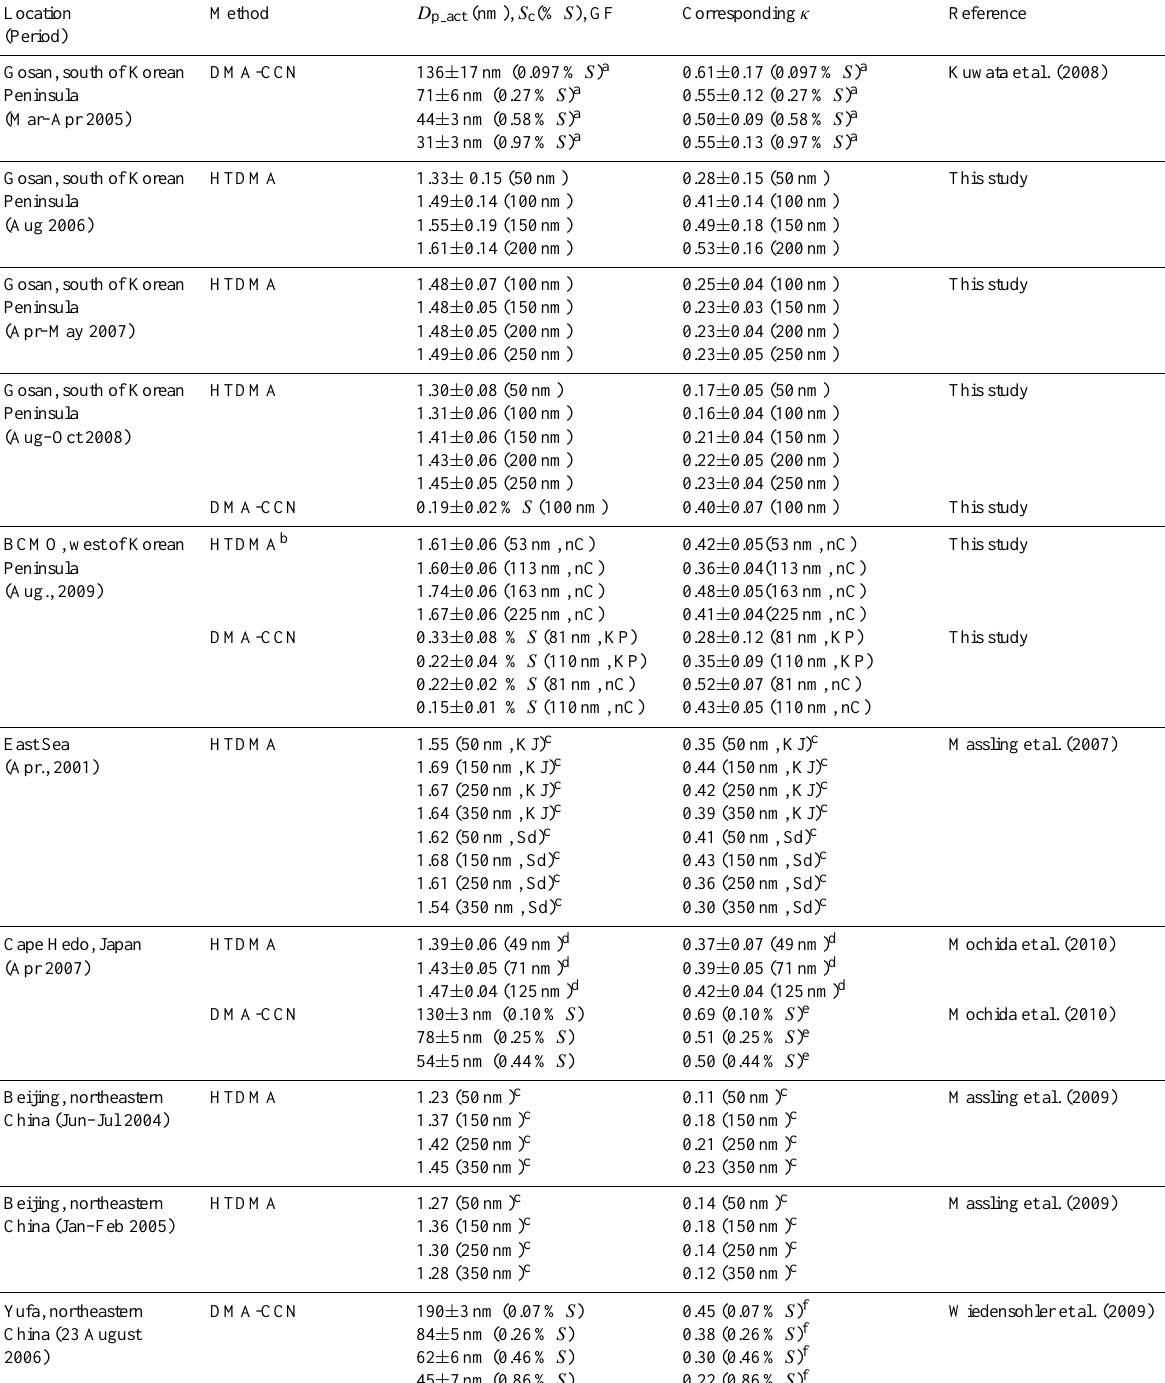
Table 3. Comparison of κ values obtained from various hygroscopicity studies in East Asia. In BCMO 2009 and Massling et al. (2007), the results were classified by air mass back trajectories (nC: northern China, KP: Korean Peninsula, KJ: Korea/Japan, Sd: Shanghai/dust).